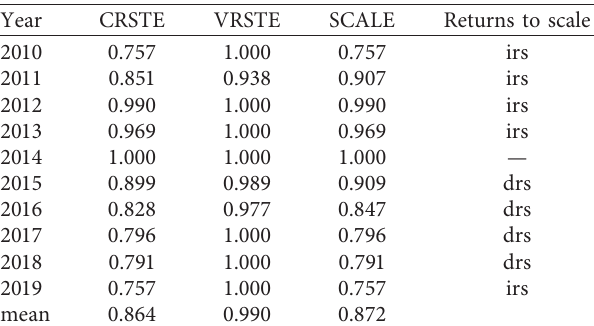
Table 3: Efficiency results of Shanghai pension